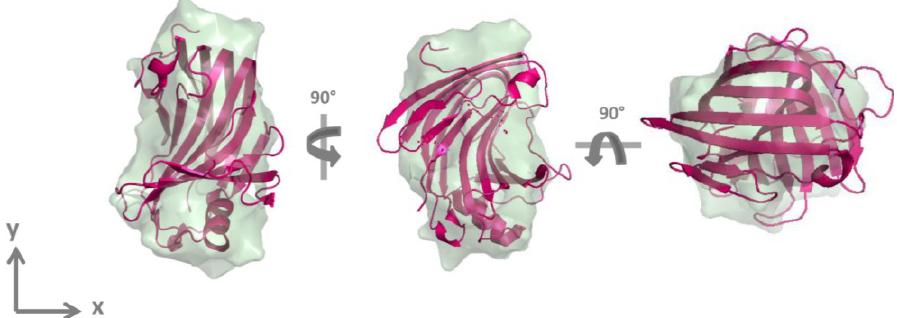
Figure 3. Structural superposition of the crystallographic structure of the homologous AaXEG (pink cartoon) and averaged DAM obtained for GtCel12A by SAXS analysis (green) shown in three different orientations. Right and center models are rotated 90° around y and x axis, respectively from the left